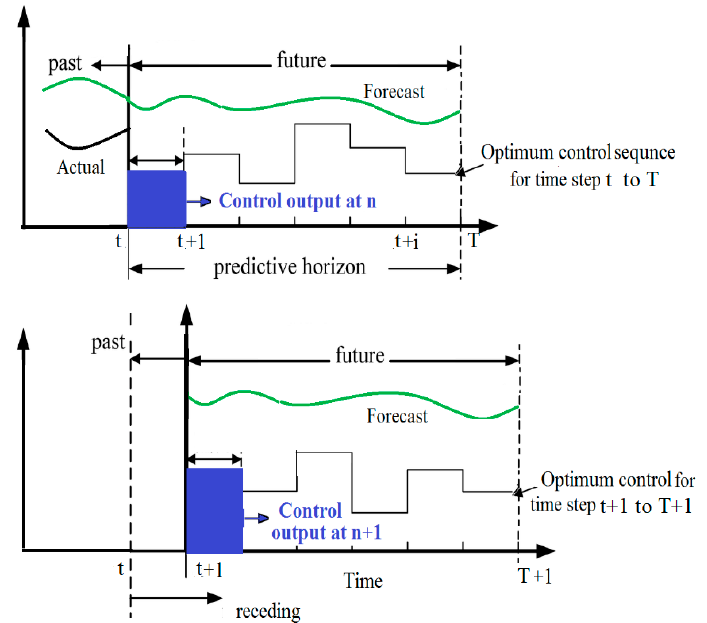
Figure 5. A simple illustration of the receding horizon used in a model predictive controller (MPC). Algorithm 1: Basic concept of MPC for RTGs network with storage device.